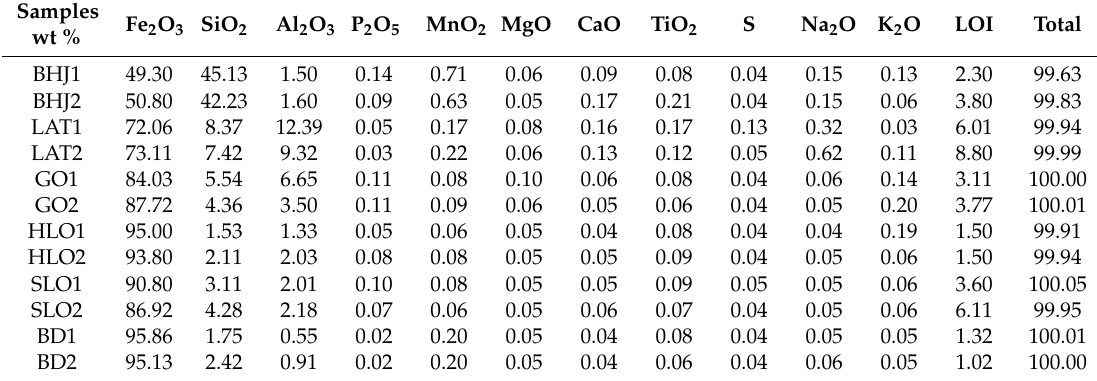
Table 2. Major Elemental variation of Kiriburu-Meghahatuburu BHJ and Associated iron ores in wt % (LAT: lateritic-limonitic ore; GO: goethitic ore; HLO: hard laminated ore; SLO: soft laminated ore; BD: blue